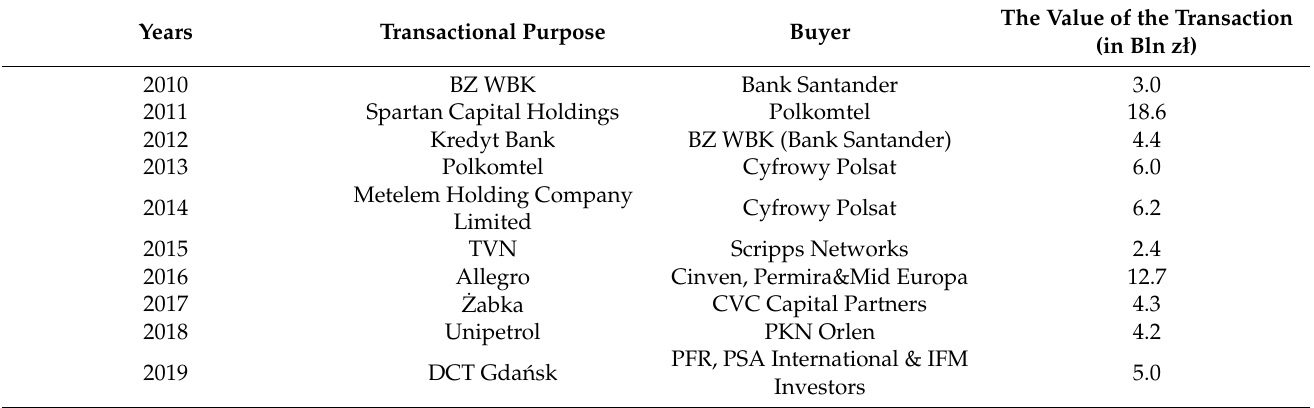
Table 3. List of the largest mergers and acquisitions in Poland from 2010–2019, in Bln zł.